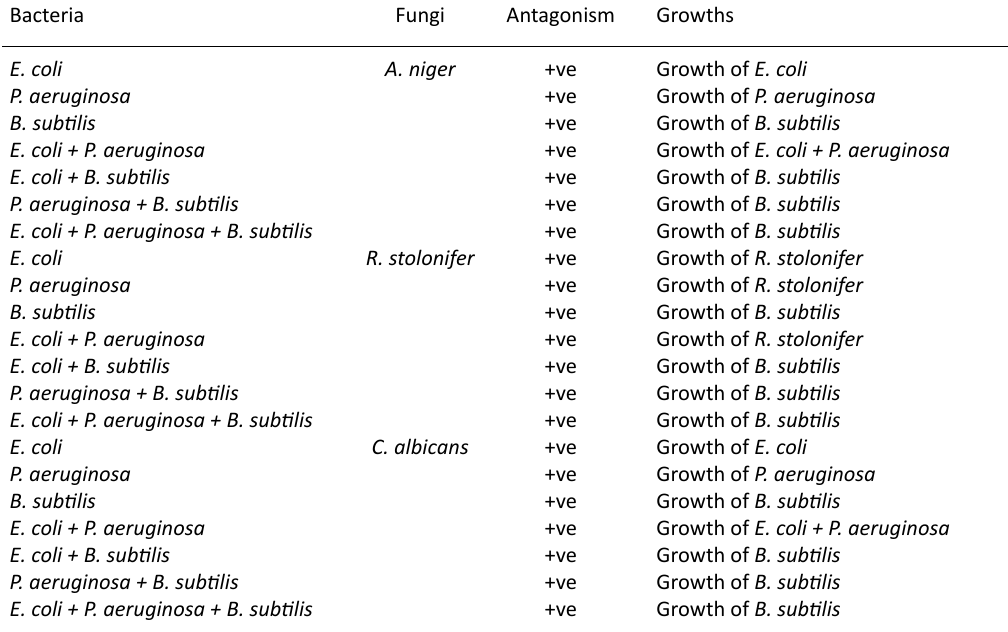
table 9. Antagonistic activity between fungi and bacteria Bacteria